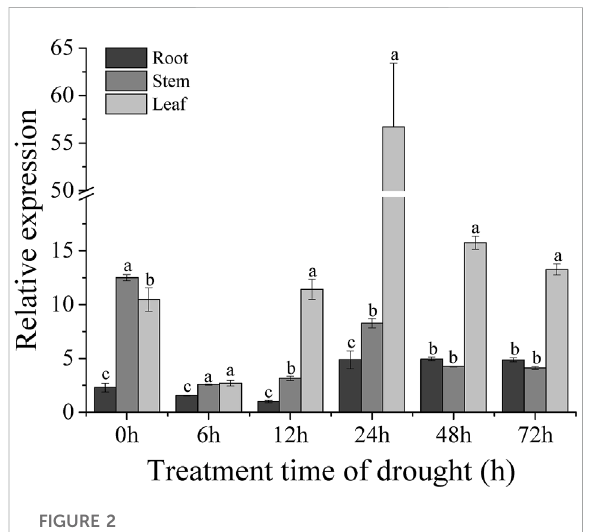
FIGURE 2 Expression analysis of IbBBX28 under PEG stress treatment. The expression of IbBBX28 at 12 h in root was set as 1-fold. Data are presented as means ± SD ( n = 3). The different letters indicate signi fi cant differences in the expression level of the IbBBX28 gene in the roots, stems, and leaves under the same time treatment ( p < 0.05) by one-way ANOVA and least signi fi cant difference (LSD)